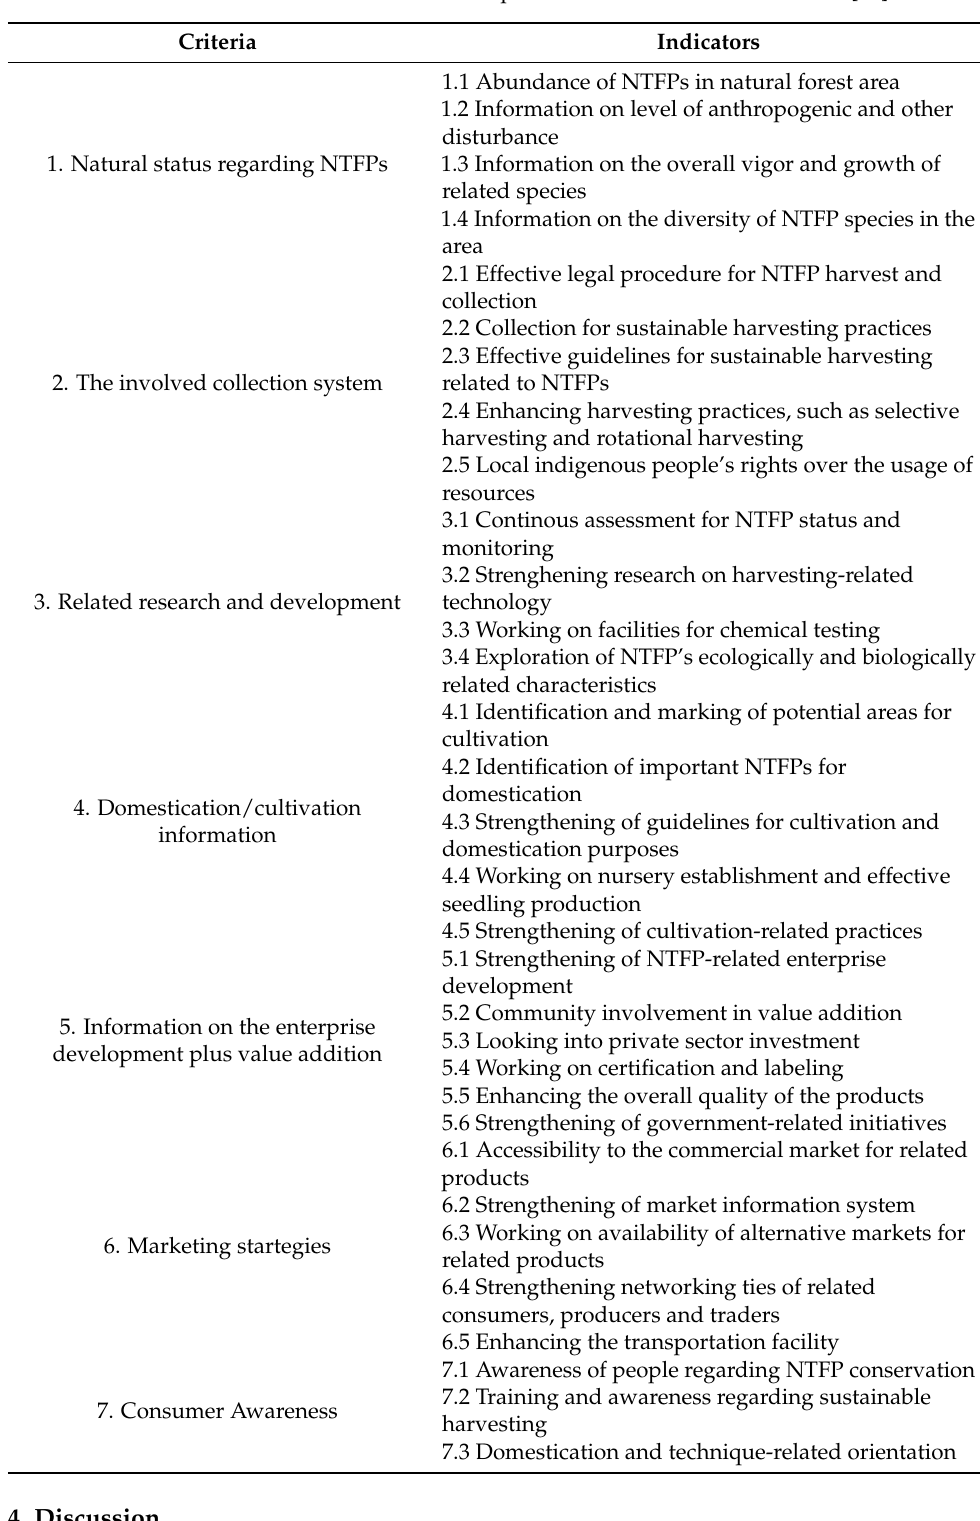
Table 1. Local set of criteria and indicators developed for NTFP certification. Source: [18].